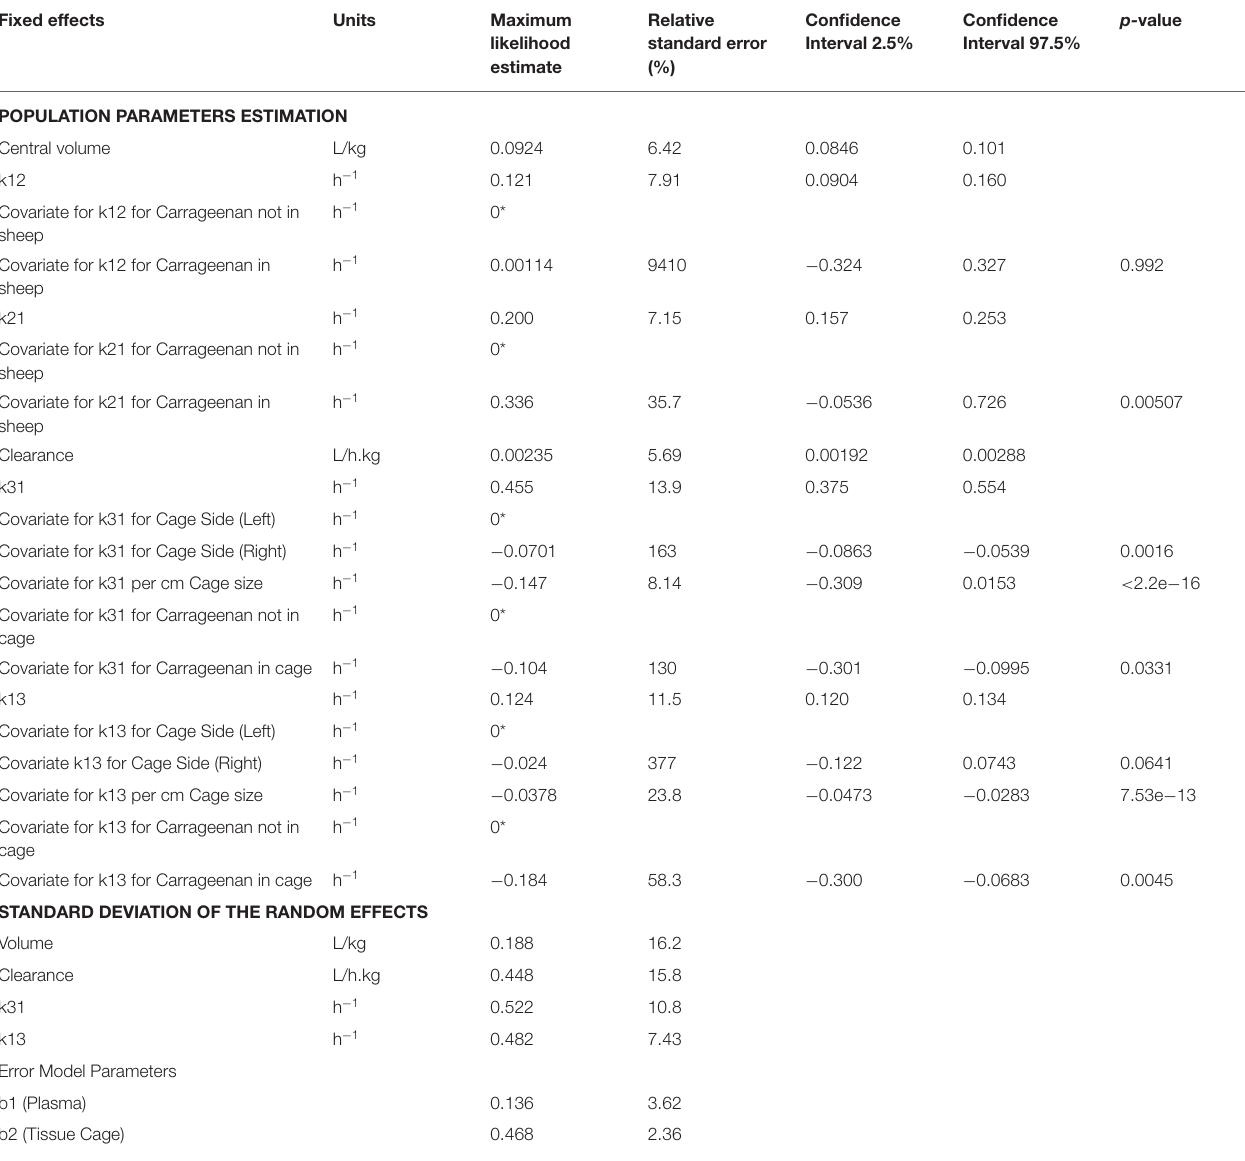
TABLE 3 | Coefficients for the model parameters estimated by